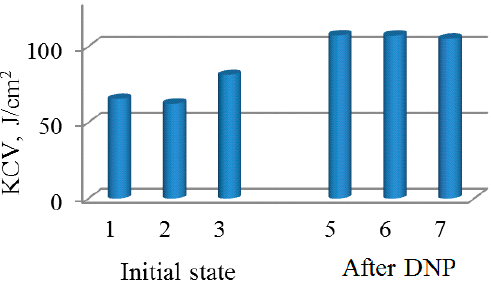
Figure 11. Impact toughness of the VT23M alloy for impact testing in the initial state and after DNP.